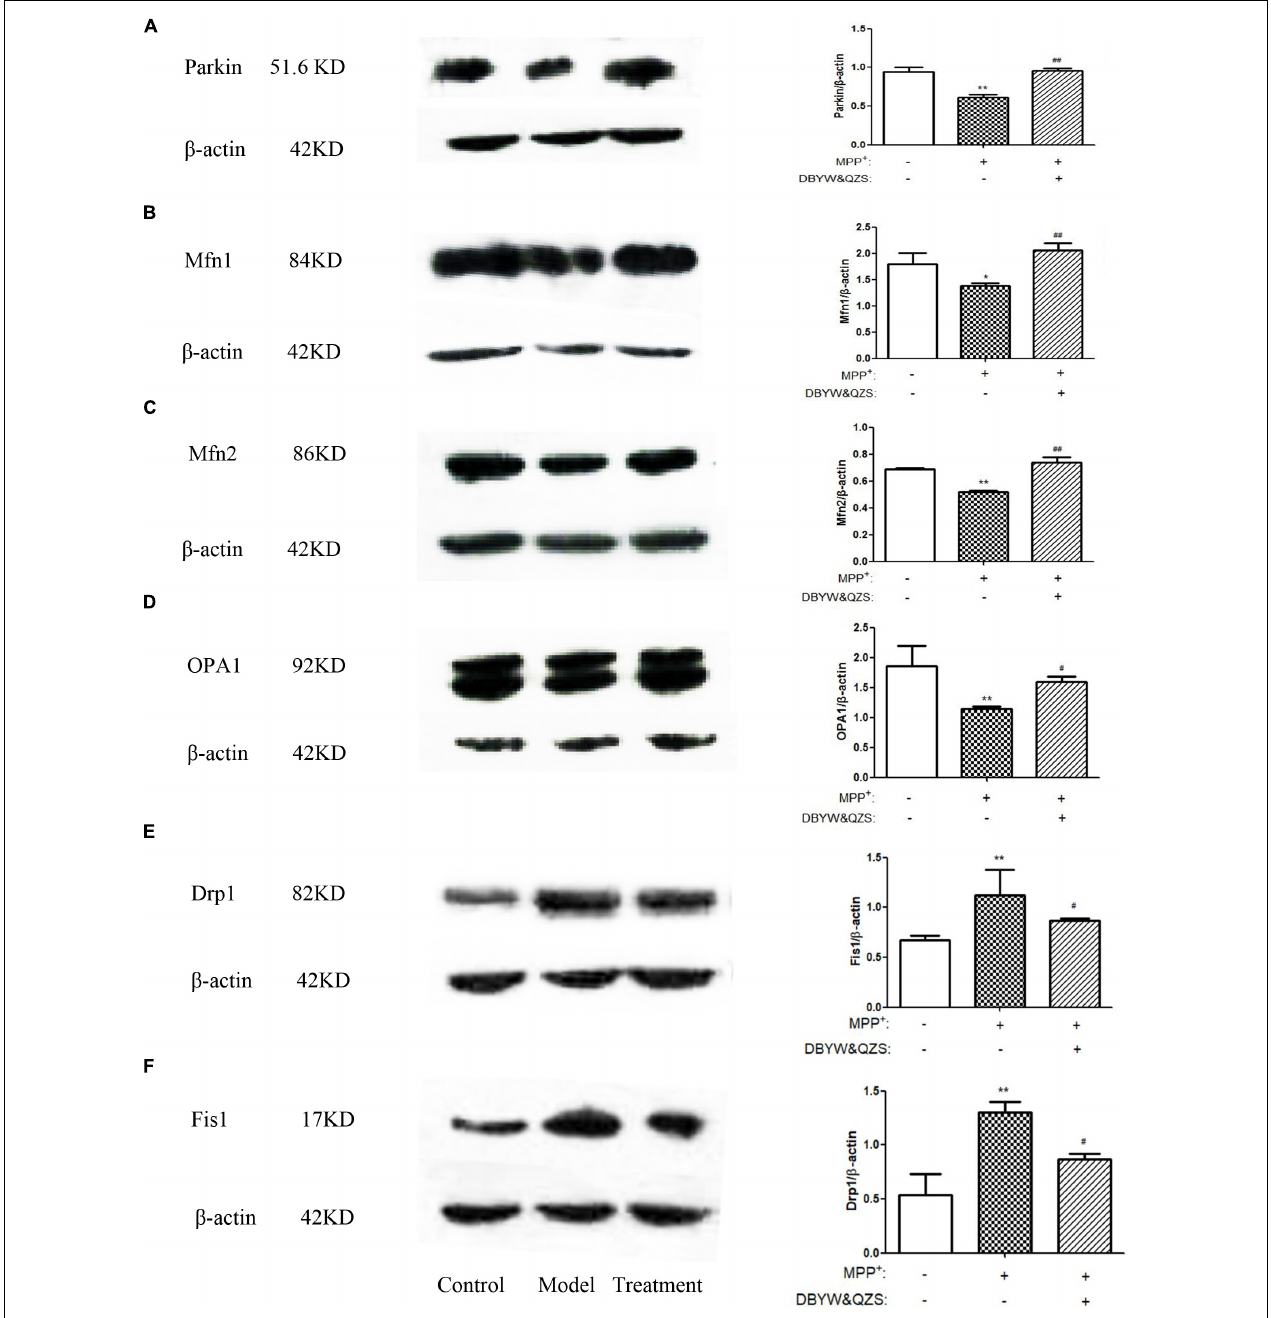
FIGURE 4 | Effect of DBYW and QZS on the expression of Parkin protein and mitochondrial fission and fusion proteins. (A) Representative western blots for Parkin and β -actin were shown. And the right bar graph showed the quantification data in arbitrary units (AU) from three independent experiments for the relative level of Parkin, after normalization with respect to β -actin. Experimental groups and treatments were described in Table 2 in the Methodology. Data were expressed as mean ± SD ( N = 3). Compared with the control group, ∗ P < 0.05; ∗∗ P < 0.01; Compared with the model group, ## P < 0.01. (B) Representative western blots for Mfn1 and β -actin were shown. (C) Representative western blots for Mfn2 and β -actin were shown. (D) Representative western blots for OPA1 and β -actin were shown. (E) Representative western blots for Drp1 and β -actin were shown. (F) Representative western blots for Fis1 and β -actin were